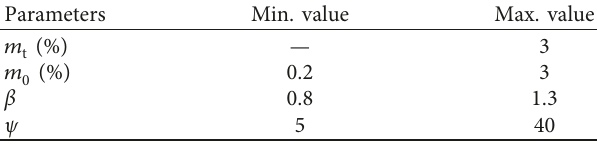
Table 1: Parameter variation domain for TMDs.